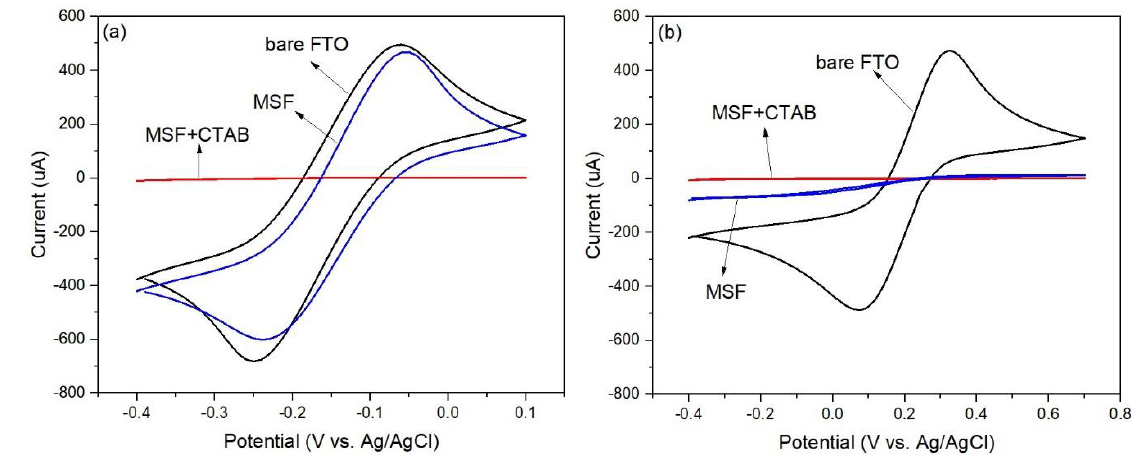
Figure 2. Cyclic voltammograms of MSFs before/after surfactant removal were recorded in 0.1 M NaNO 3 solution containing 5 mM Ru(NH 3 ) 63+ ( a ) and 5 mM Fe(CN) 63− ( b ) at a scan rate of 0 . 1 Vs −1 .